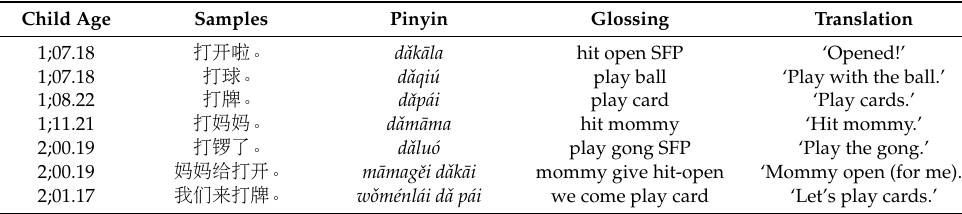
Table 3. Sample utterances containing the target verb 打 dˇa in child speech 2